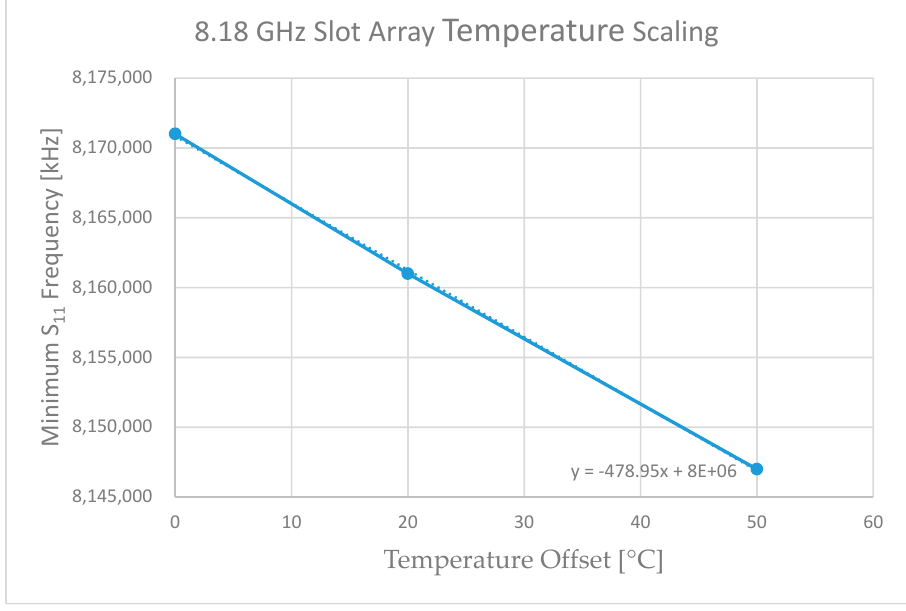
Figure 4. 8.18 GHz slot array temperature scaling.